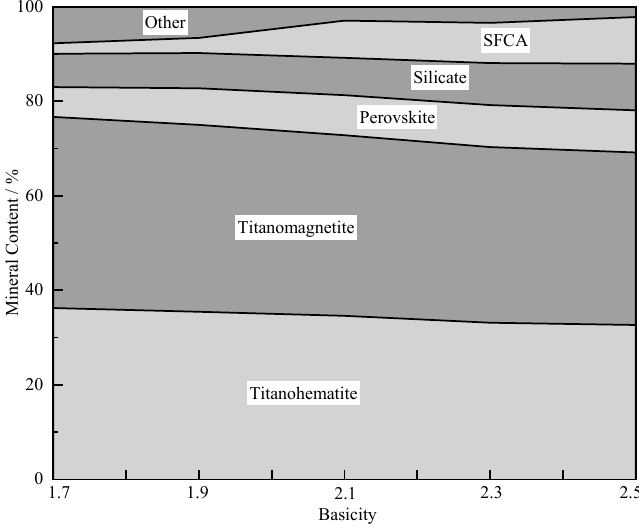
Figure 5. E ff ect of basicity on the mineral composition of HCVTM Figure 5. Effect of basicity on the mineral composition of HCVTM sinters. Figure 5. Effect of basicity on the mineral composition of HCVTM sinters.